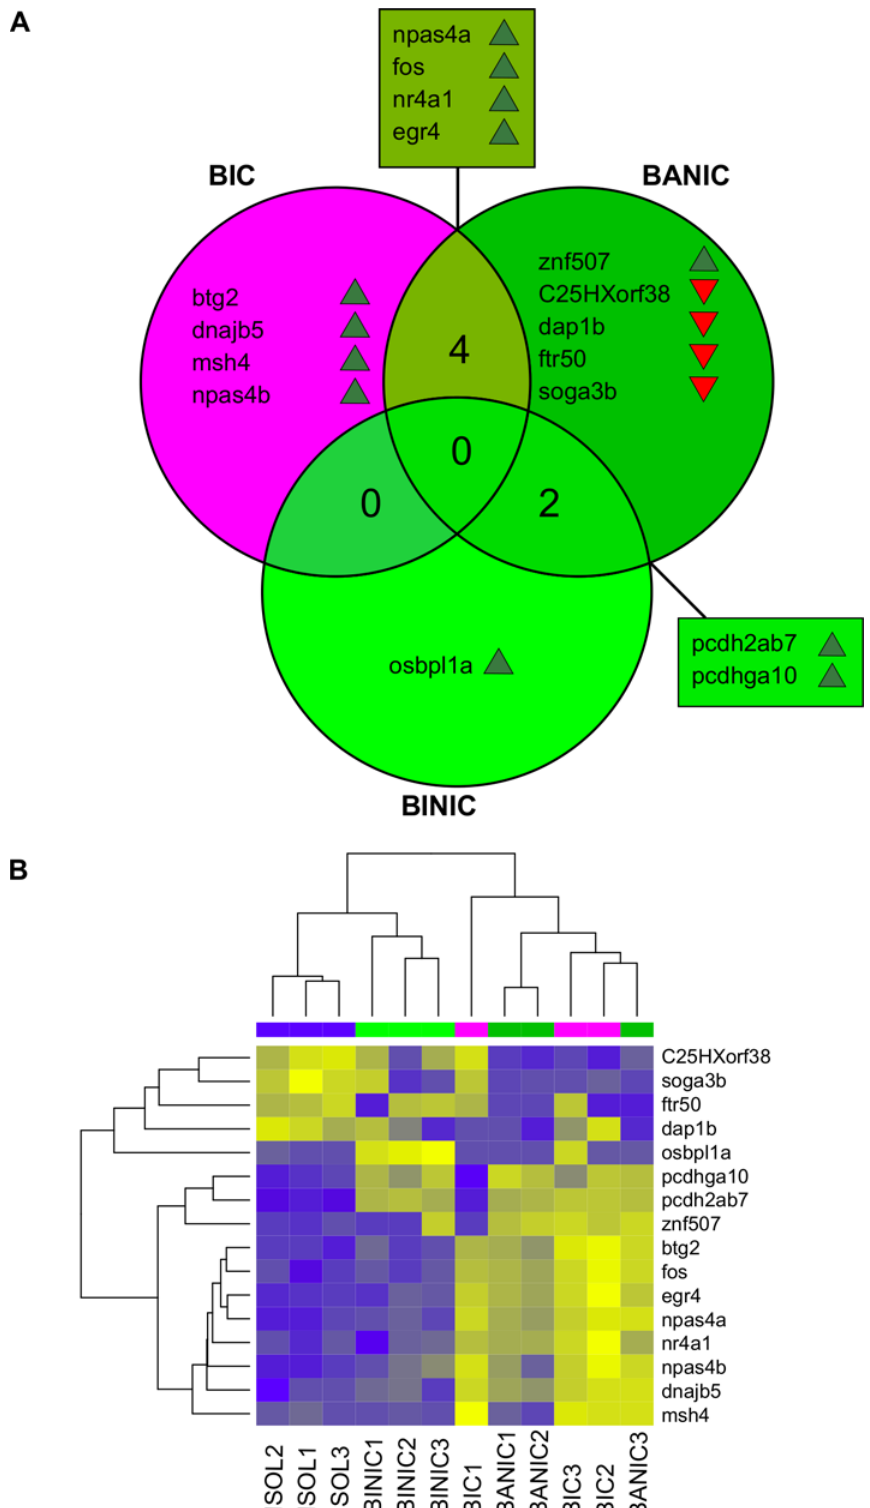
Fig 2. Changes in gene expression in the brain of bystander zebrafish. (A) Venn diagram showing DE genes between behavioral groups (BIC, bystanders to interacting conspecifics; BANIC, bystanders